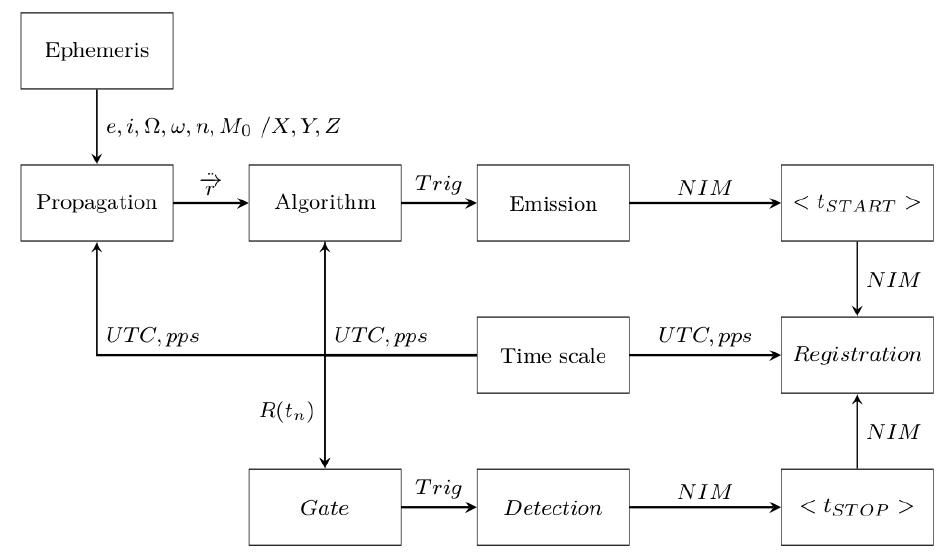
Figure 5. Block diagram of the laser ranging